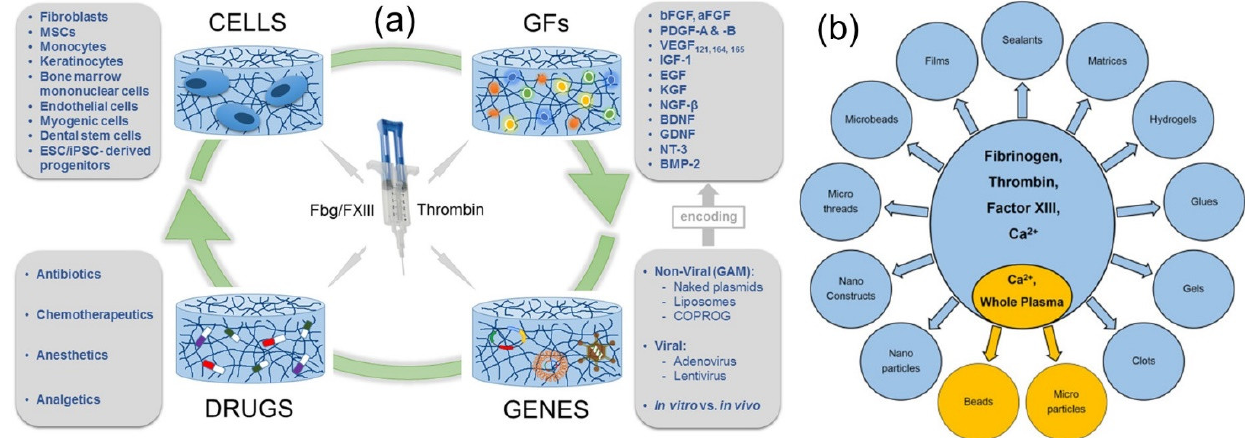
Figure 8. ( a ) Experimental and clinical delivery applications of fibrin in wound healing. Fibrin has been used to deliver cells, drugs, growth factors or gene vectors, and combinations thereof. GF: